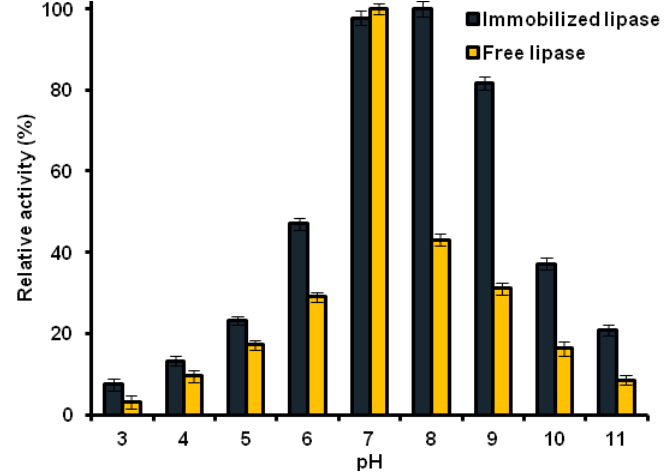
Figure 8. Effect of pH on activity of the native and immobilized lipase.